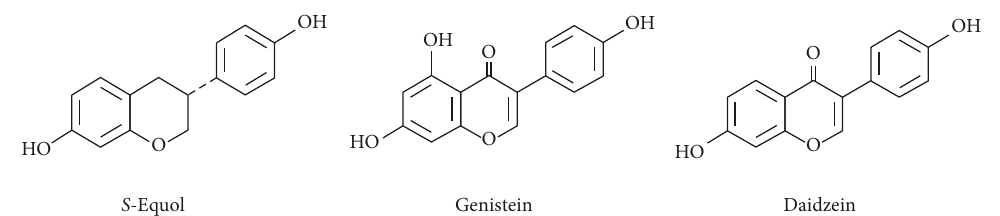
Figure 1: Chemical structures of S -equol, genistein, and